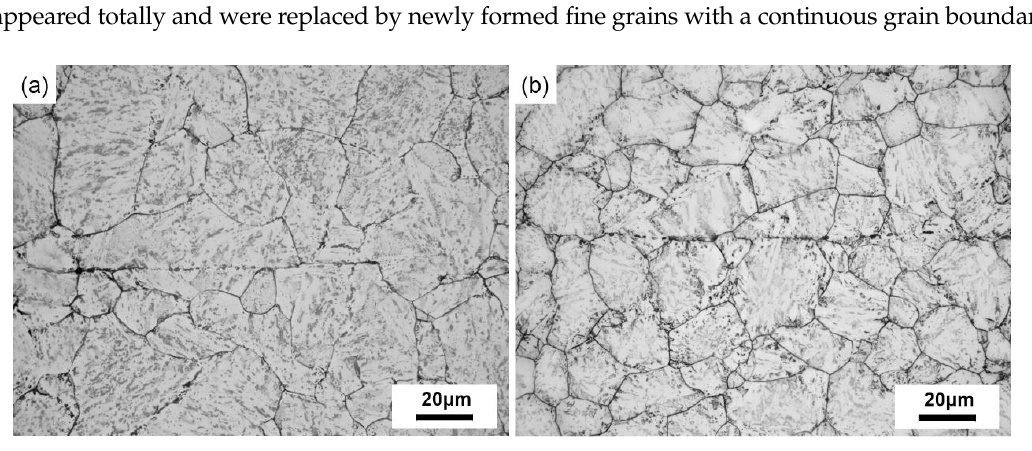
Figure 7. The microstructure of the SA 508–3 after compression at 950 °C with different reduction ratios: ( a ) 10%, ( b ) 20%, and ( c ) 30%. 3.2. Tensile Properties Recovery The tensile properties of SA 508–3 at room temperature should meet the following requirements: the ultimate tensile strength is 550 MPa~700 MPa, the elongation is more than 18%, and the reduction of area is more than 38%. Figure 8 shows the room-temperature tensile macroscopic fractographs under different reduction ratios, healing at 950 °C for 10 h. When the reduction ratio was 10%, there was no necking in the tensile test. When the reduction ratios were above 20%, the apparent extension and displacement occurred on the other two tensile samples. The tensile fracture positions were located in the matrix rather than in the crack healing zone, which indicated the tensile strength of the crack healing zone was higher than the matrix. Figure 8. Room-temperature tensile macroscopic fractographs of the crack healing zones under different reduction ratios, healing at 950 °C for 10 h.